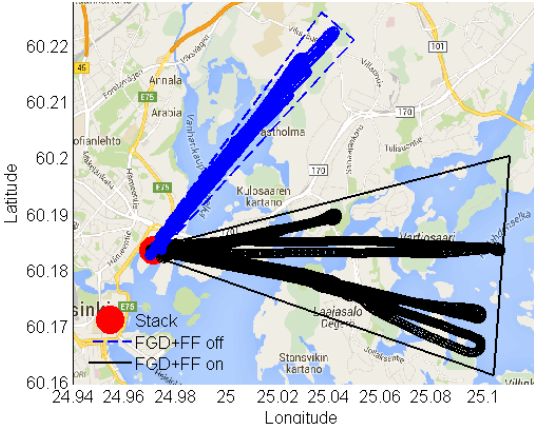
Figure 1. Helicopter flight routes. The wind blew at an angle of 216 ± 5.51 ◦ (based on lidar data) and the flight direction was 213 ± 4.14 ◦ (based on GPS data for helicopter) in FGD + FF off (blue circles). Corresponding angles for FGD + FF on (black cir- cles) were 220 ± 6.25 ◦ (wind direction based on lidar data) and 223 ± 5.66 ◦ (flight direction based on GPS data for helicopter). The triangular shapes (black and blue lines) show the helicopter GPS co- ordinates that have been taken into account in the